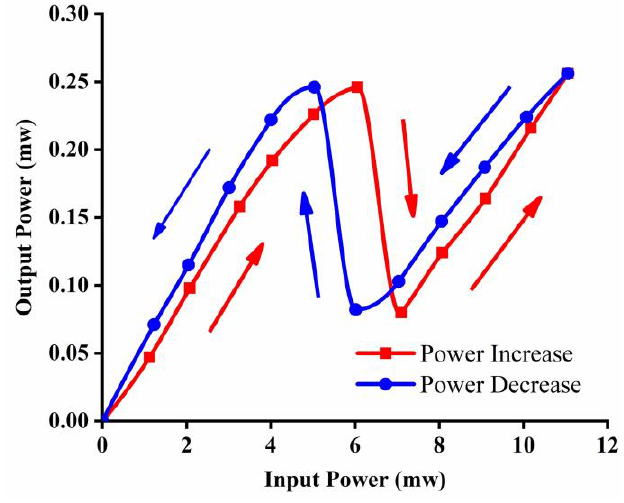
Figure 7. Optical bistability performance of the tunable gourd-shaped ring resonator system.